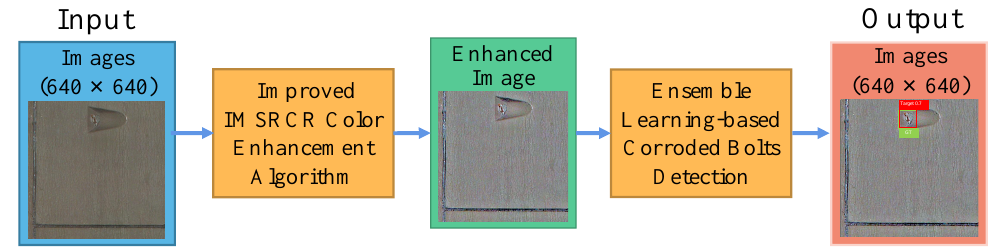
Figure 1. Flow chart of corroded bolt detection scheme in a dim